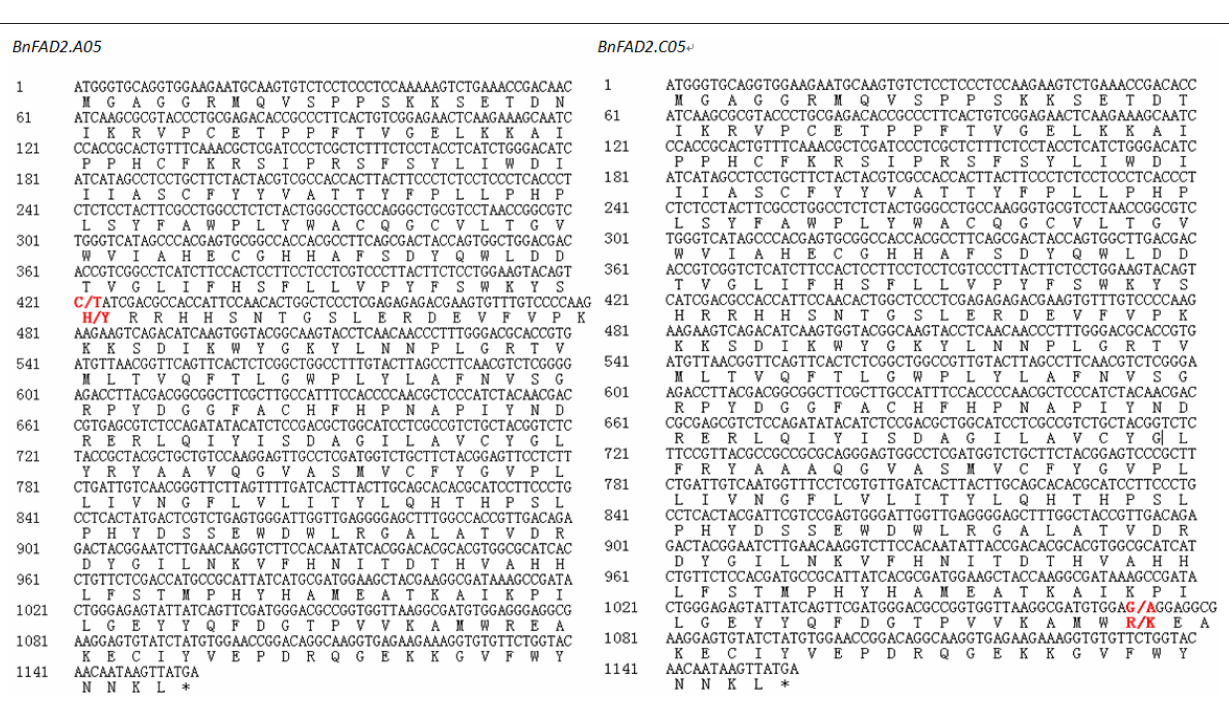
a Chromosome. b Field trials in the different years. c Additive effect. The direction of additive effect is from the allele of “E183,” while a negative additive effect indicates an allelic contribution from “FC81”. d Length of 2-LOD score confidence interval. e Percentage of the phenotypic variance explained by each QTL.